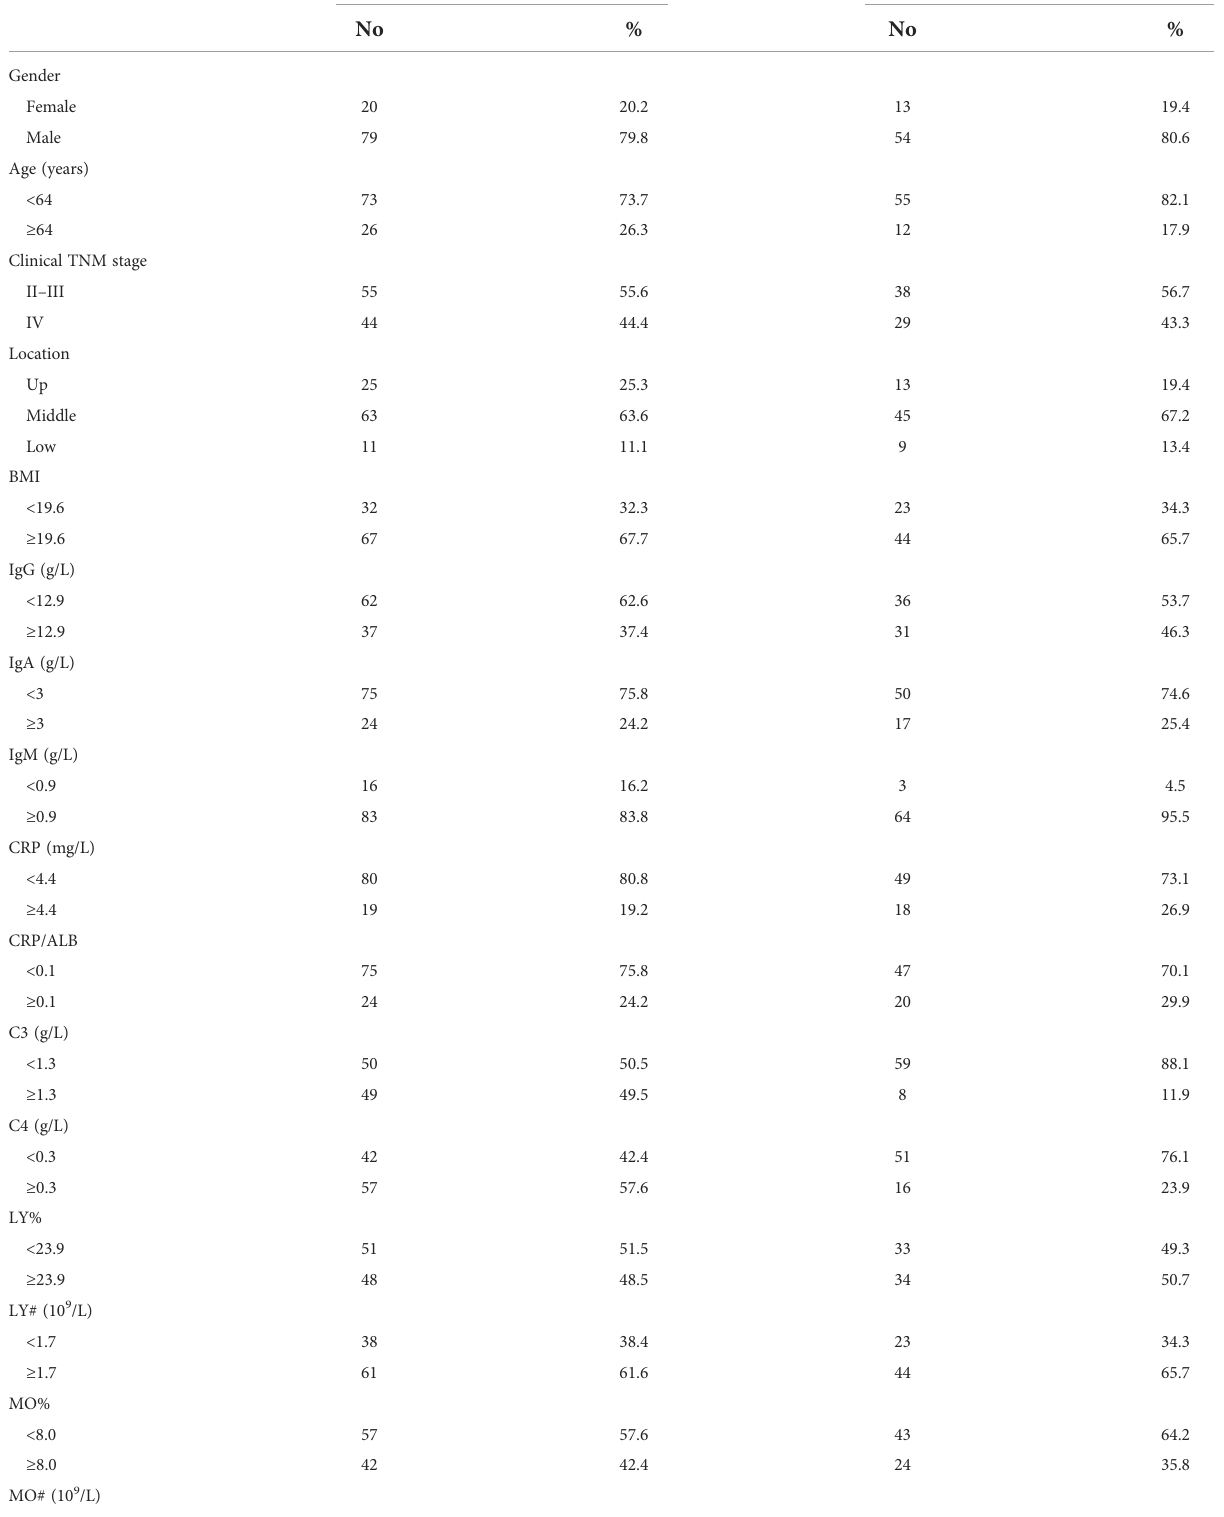
TABLE 1 Patient demographics and clinical